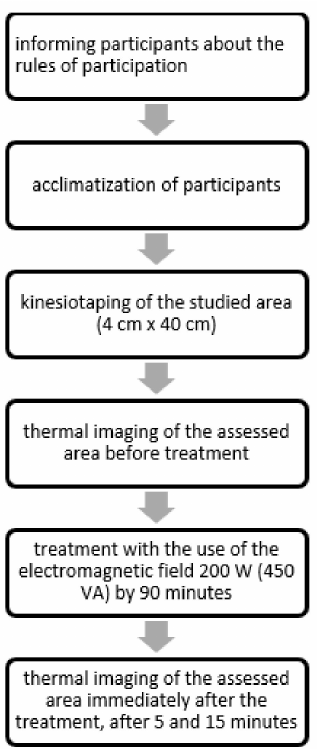
Figure 2. The method of determining the studied area (own picture).